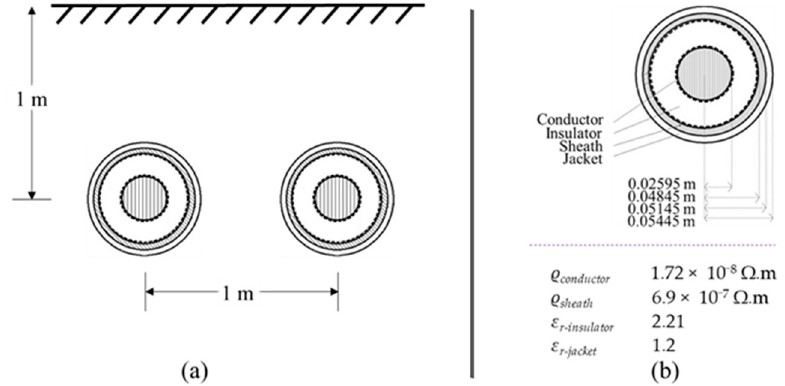
Figure 3. Underground section of mixed HVDC transmission line ( a ) layout, ( b ) dimensions and electrical properties.